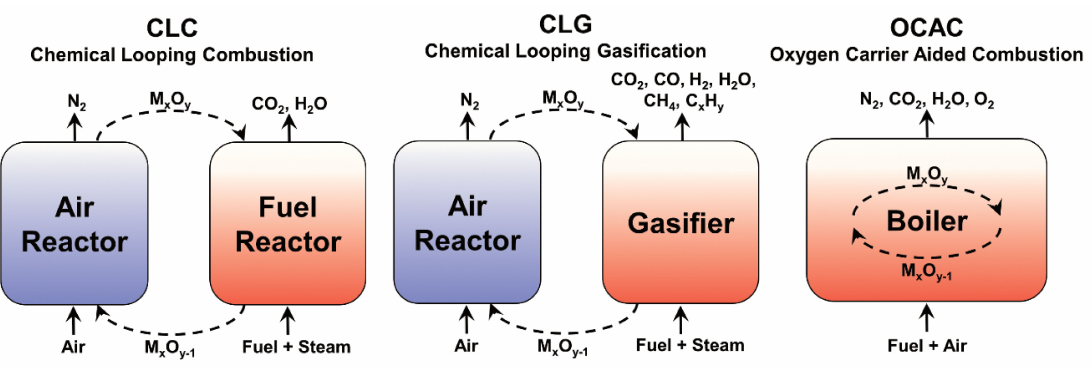
Figure 1. Simplified sketches of three different technologies utilizing metal oxide oxygen carriers (MO in the figure) to produce either separated CO 2 simultaneous with power generation (CLC), raw gasification gas with CO 2 separated into the raw gas (CLG), or oxygen carriers in a conventional boiler for oxygen buffering